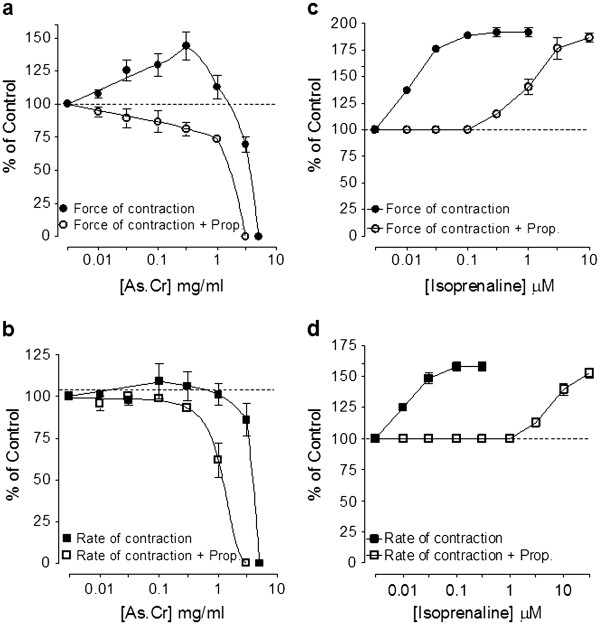
Effect of (a andb) the crude extractofA. spinosus(As.Cr) and (c andd) isoprenaline in theabsence and presence ofpropranolol (Prop.,1 μM) onforce and rate ofspontaneous contractions of isolatedguinea-pig right atria. Values are shown as mean ± S.E.M., n = 3–5.